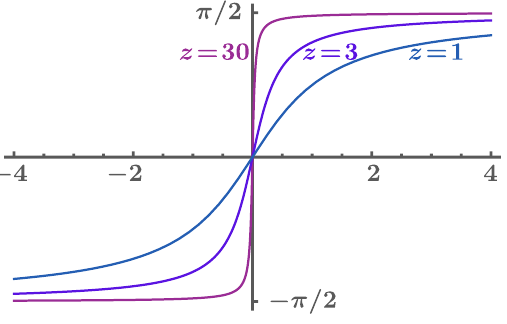
Figure 2.2: The function y = arctan ( zx ) has non-commuting limits x → 0 and z → ∞